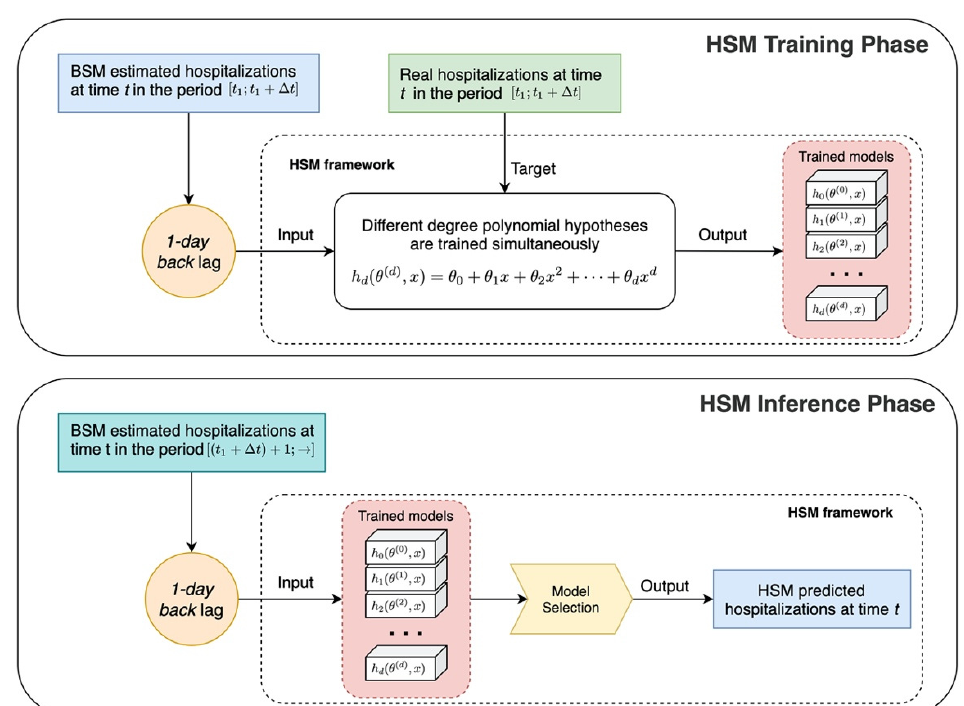
Figure 2. Hybrid Susceptible, Exposed, Infected, and Recovered (SEIR) Model (HSM) framework Training and Inference phases.